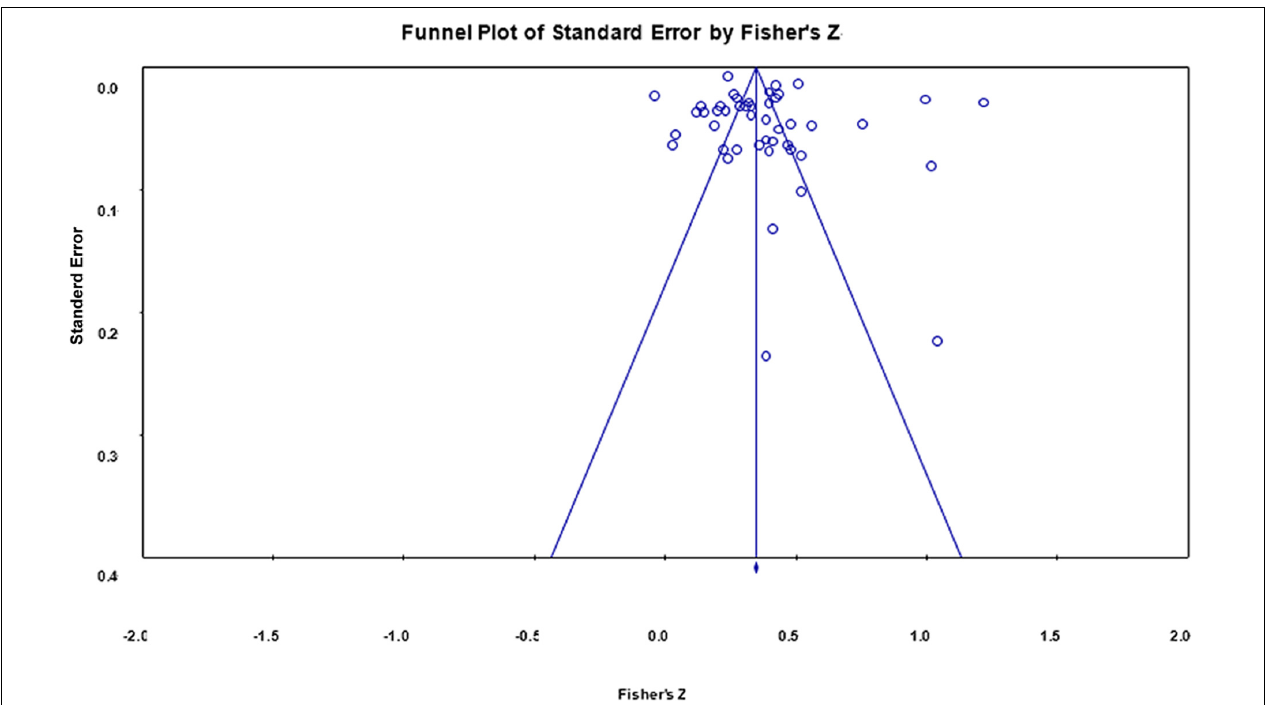
FIGURE 4 | Funnel plot of effect sizes of the correlation between impulsivity indicator and Internet addiction.